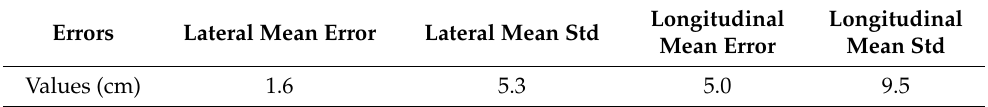
Table 5. Localization algorithm performance. The performance of the algorithm was evaluated by comparing the path from localization to the RTK